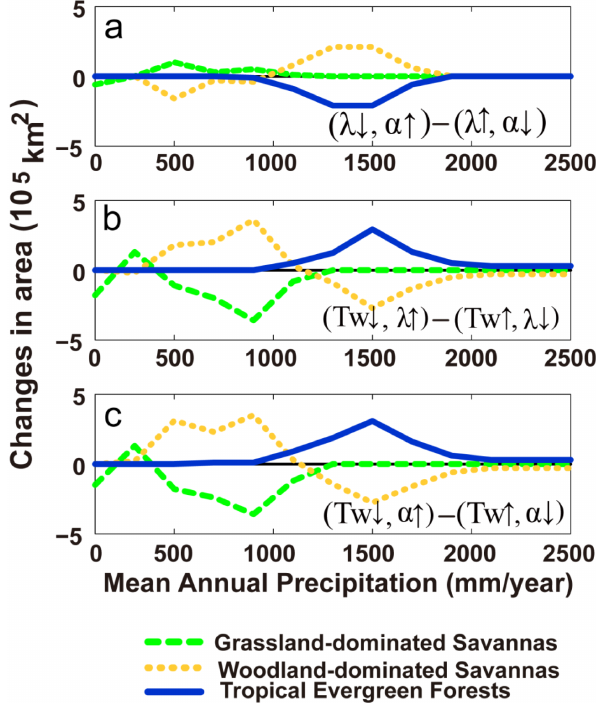
Figure 3. Differences in simulated dominated biomes in the